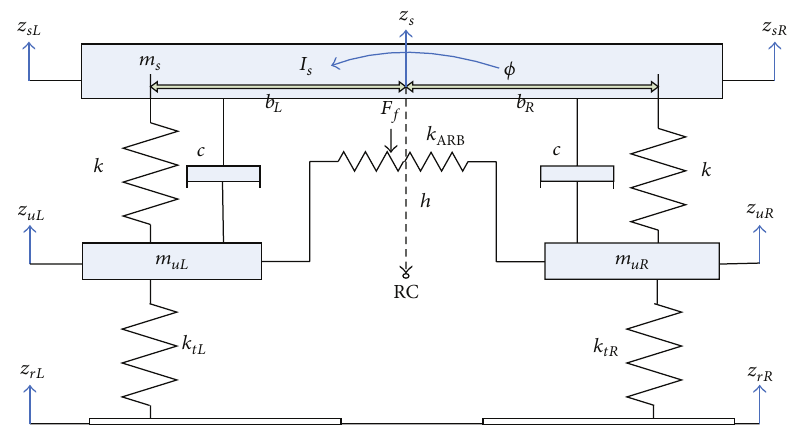
Figure 2: Half car model of a vehicle from front